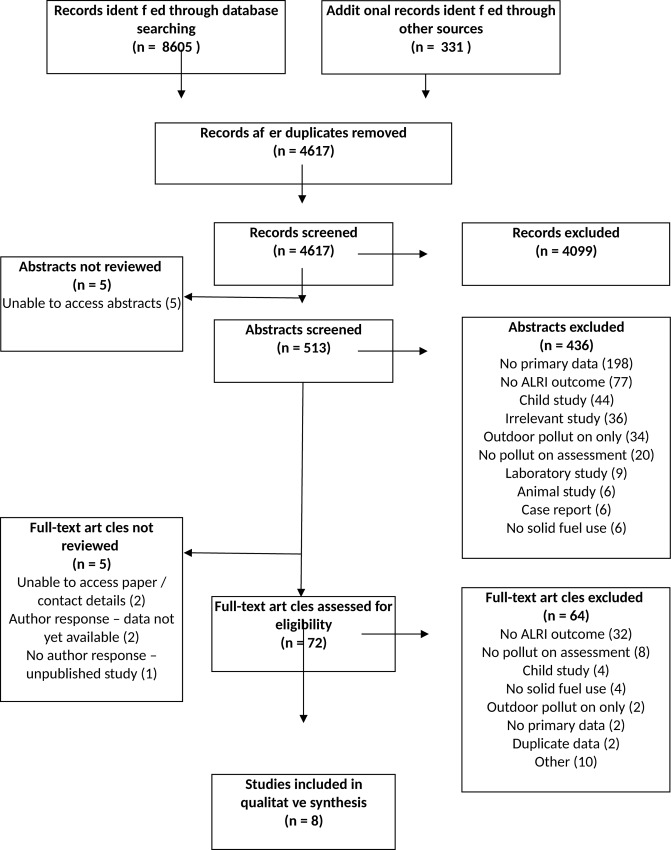
PRISMA Flow Chart A flow chart depicting the inclusion and exclusion of identified studies